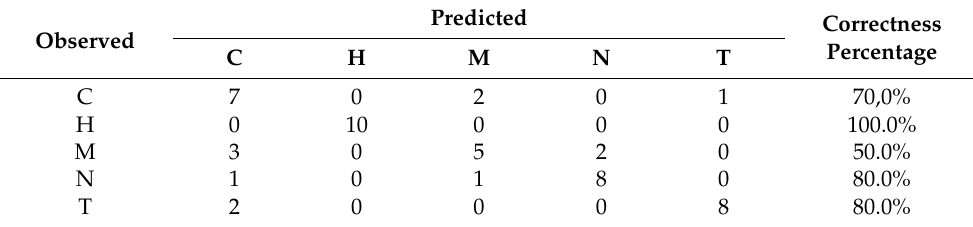
Table 3. Confusion matrix of the multinomial logistic regression model computed on the as-is dataset.